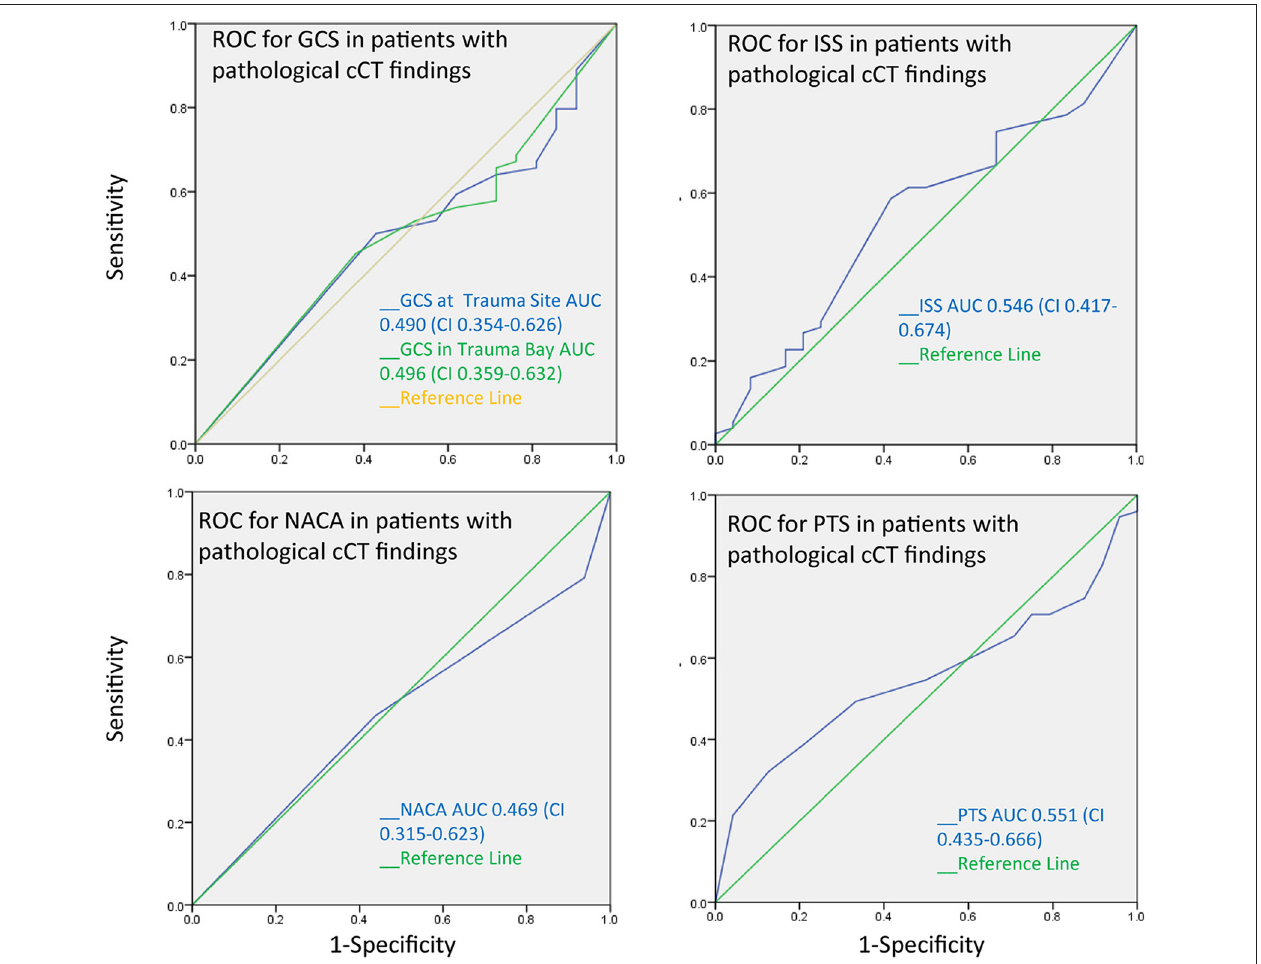
FIGURE 3 | Receiver operating characteristics curves for pathological cranial CT findings. The area under the curve is near 0.5 for all trauma scores tested. Scores therefore cannot distinguish between patients with and without pathological CT findings.